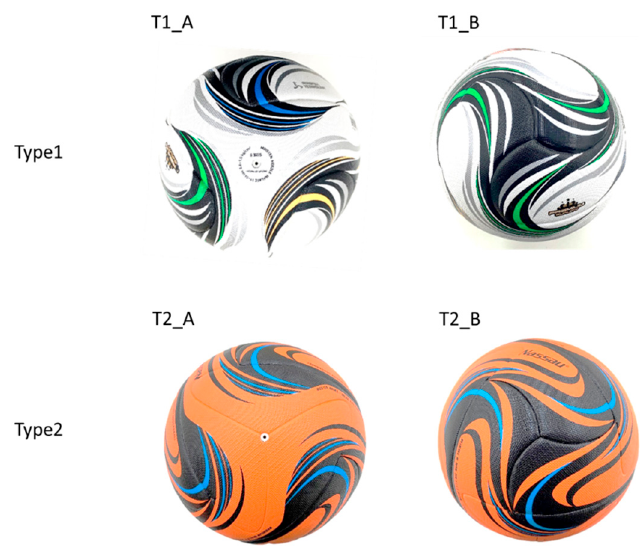
Figure 4. Soccer balls used in this experiment and their panel orientations.